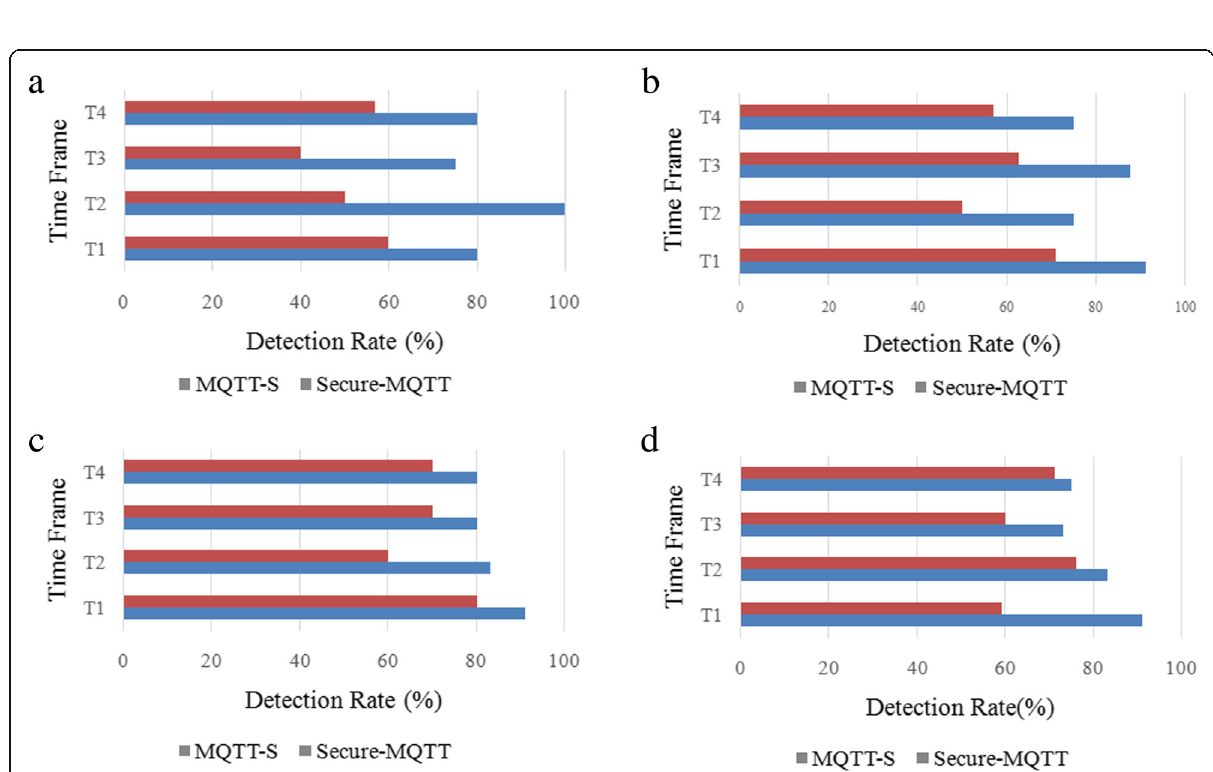
Fig. 10 a – d Attack detection rate in different